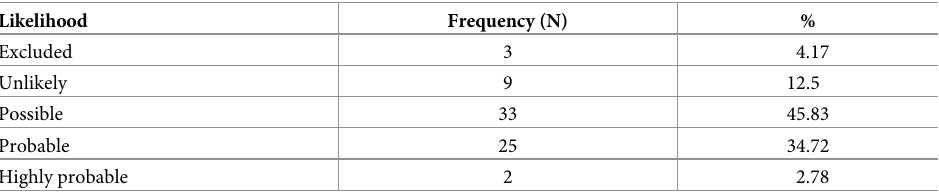
Table 3. Final updated RUCAM causality assessment